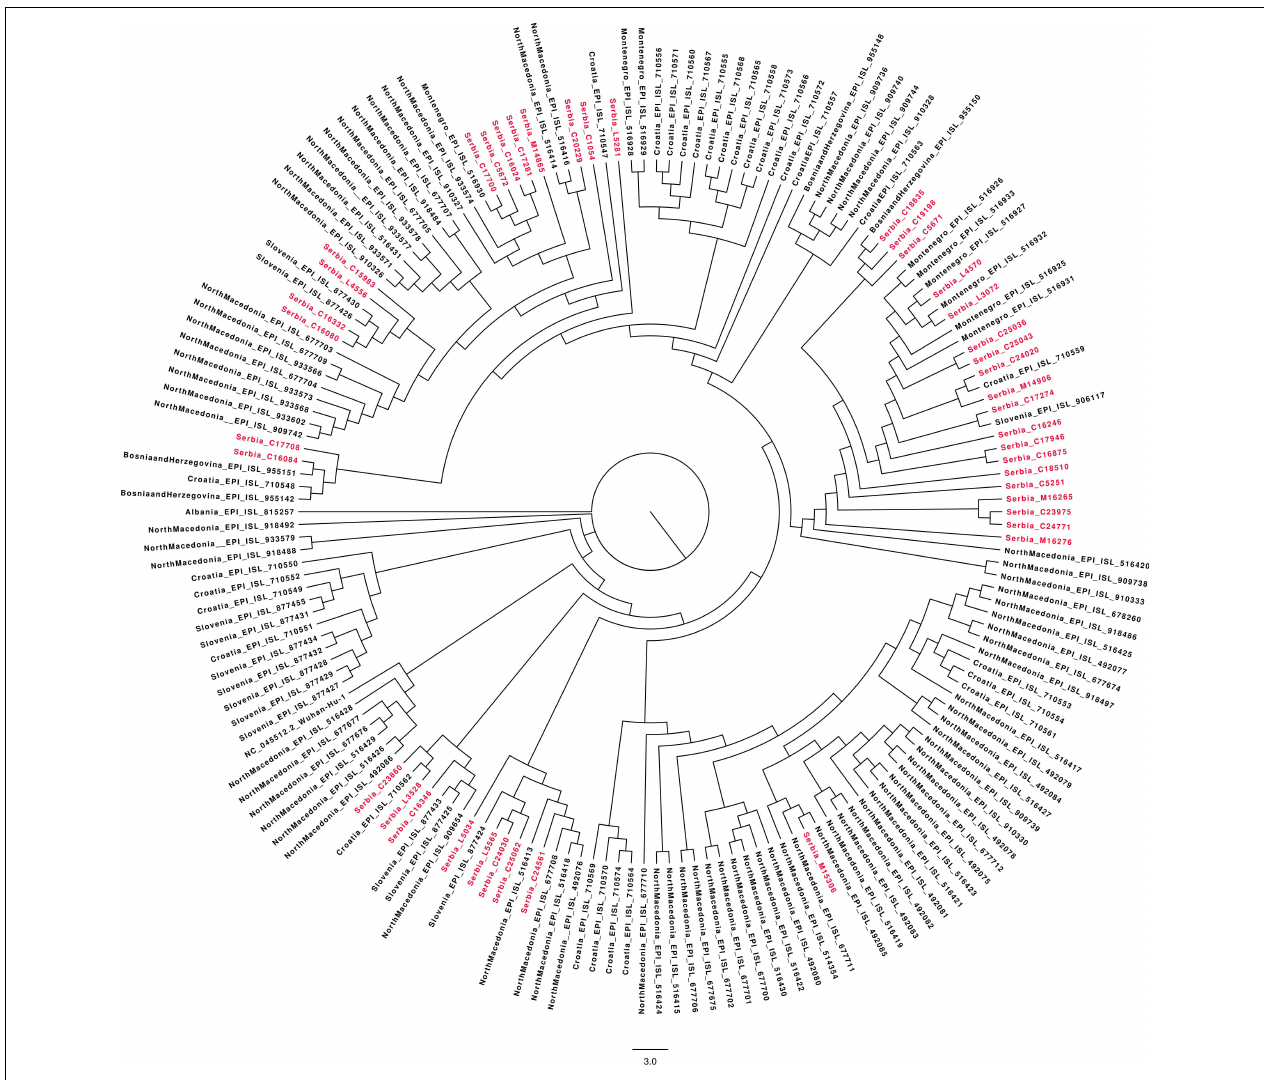
FIGURE 2 | Maximum-likelihood (ML) phylogenetic tree generated by the W-IQ-TREE web server under the best-fit GTR + G model of evolution, based on whole genome sequence of 41 Serbian SARS CoV2 isolates and all sequences from neighboring Balkan countries (Albania, Bosnia–Herzegovina, North Macedonia, Montenegro, Slovenia, and Croatia) from June–October 2020 were retrieved from GISAID database ( n = 160). The reference sequence was Wuhan-Hu-1 NC 045512.2. The Serbian isolates are highlighted in the